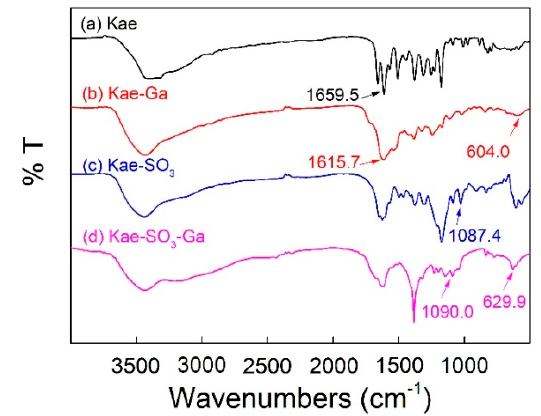
Figure 3. Fourier transform infrared (FT-IR) spectra of ( a ) Kae, ( b ) Kae-Ga, ( c ) Kae-SO 3 and ( d ) Kae-SO 3 -Ga, respectively. Table 4. Frequencies of characteristic absorption bands in Fourier transform infrared (FT-IR) spectra of Kae, Kae-Ga, Kae-SO 3 and Kae-SO 3 -Ga, respectively.